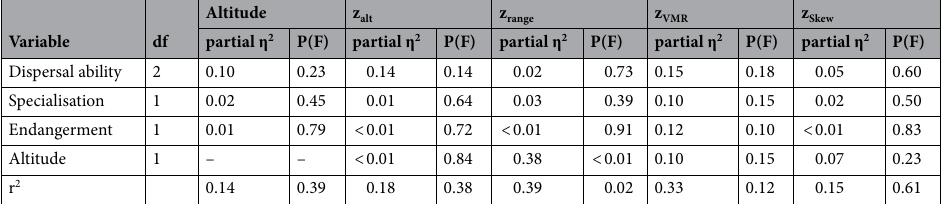
Table 1. General linear modelling to infer trait specific variation in the temporal shifts in altitude and altitudinal range sizes. Medium altitude served as covariate. Given are effect sizes (partial η 2 and r 2 values) and parametric